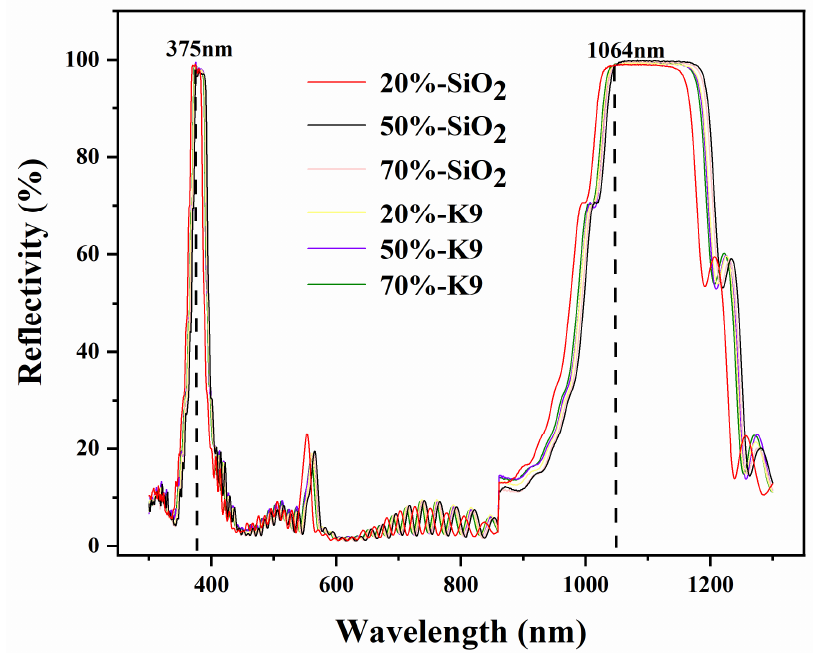
Figure 4. The spectra of high-reflectivity dielectric coatings based on SiO 2 and K9 in different humidity environments.